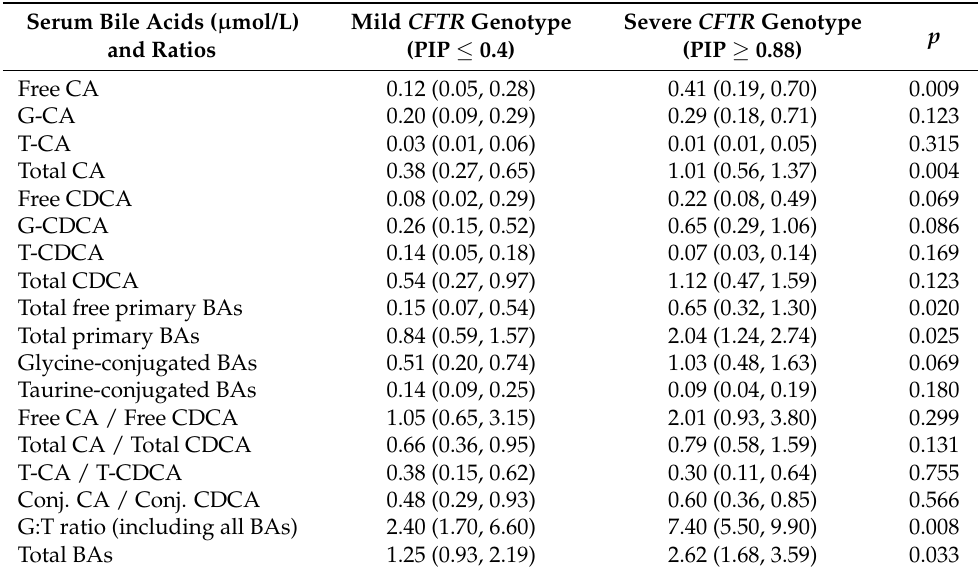
Table 2. Serum primary bile acids in pwCF classified according to their pancreatic insufficiency prevalence (PIP) score (median and [Q 1 , Q 3